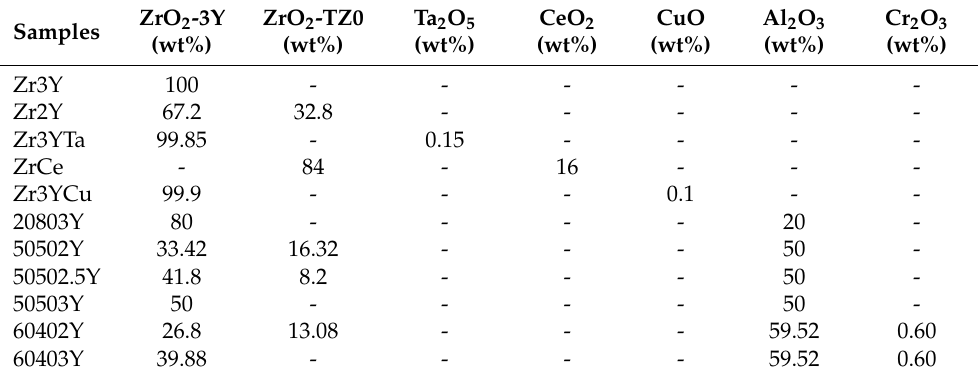
Table 1. List of zirconia and zirconia composites considered in the present study.